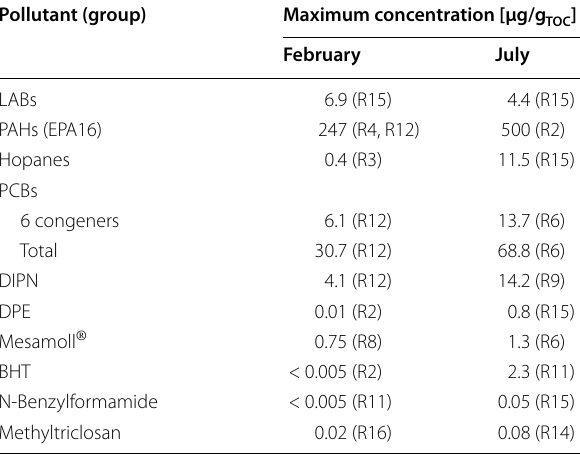
Table 1 Maximum concentrations [µg/g sampling locations of different pollutants/pollutant groups Pollutant (group) Maximum concentration [µg/g TOC